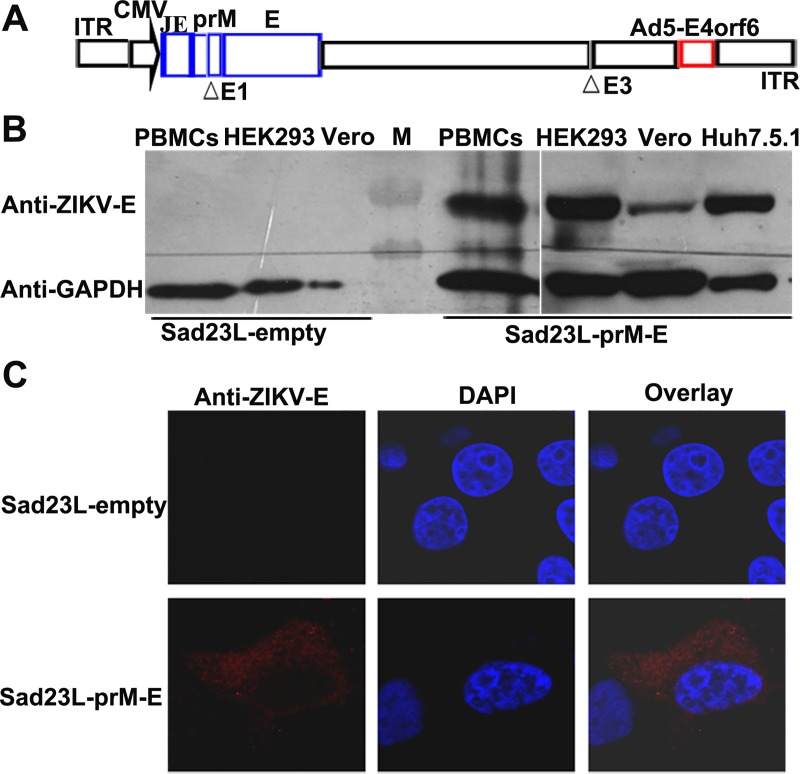
Characteristics of novel Sad23L-prM-E vaccine.(A) Genomic construct of Sad23L-prM-E vaccine. Cytomegalovirus promoter (CMV), Japanese encephalitis virus signal peptide (JE signal) sequences and ZIKV prM-E genes were inserted into the deleted E1 region of simian adenovirus type 23 genome (SAdV23), the initial E3 region was deleted and E4orf6 was replaced by the corresponding element of Ad5-E4orf6. ITR indicates inverted terminal repeat sequence. (B) E protein expressions from Sad23L-prM-E virus infected naïve marmoset’s PBMCs, HEK-293, Vero and Huh7.1.5 cells were analyzed by Western blot, while Sad23L-empty virus infected cells were used as mock controls. Anti-ZIKV and anti-GAPDH antibodies were used to detect E protein and internal control protein, respectively. M indicates protein marker. (C) E protein expression in Vero cells was detected by immunofluorescence staining.